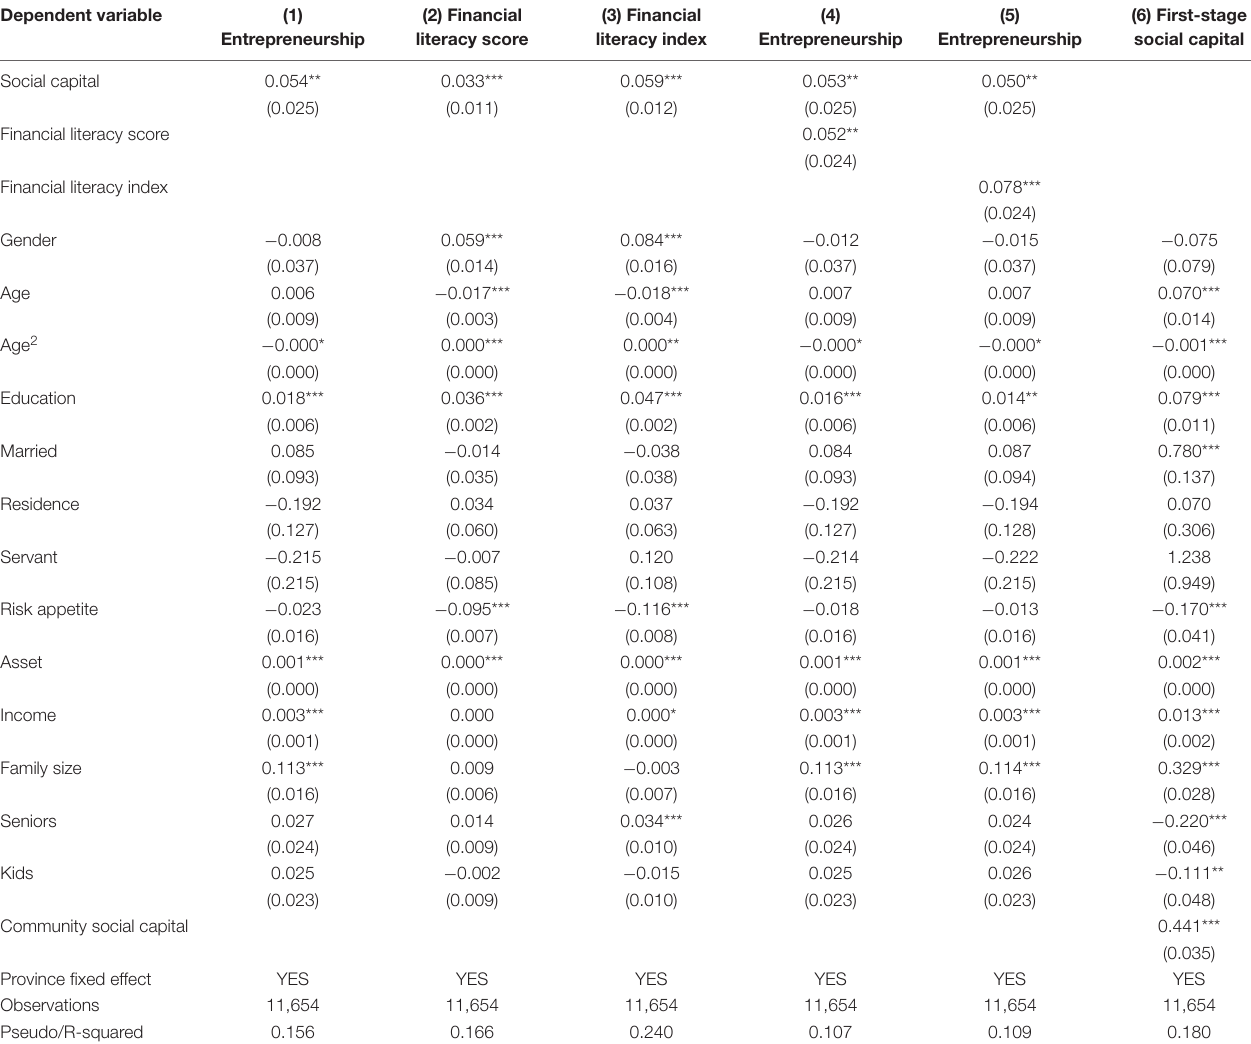
TABLE 8 | IV estimation of the effect of social capital on entrepreneurship and financial literacy. Dependent